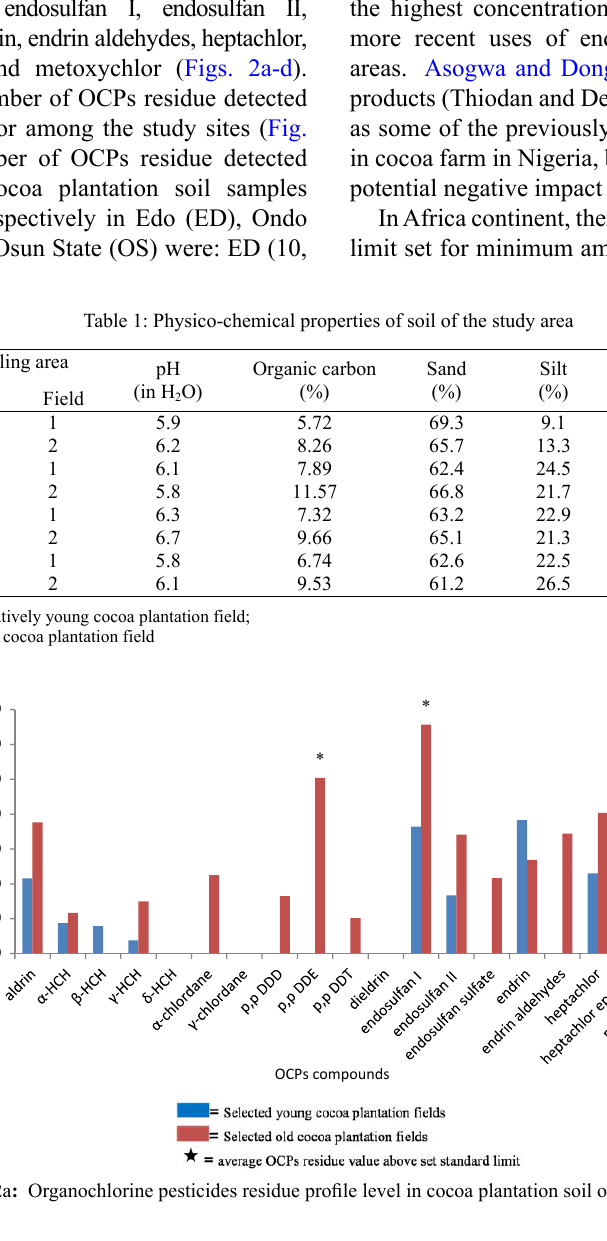
Fig. 2b : Organochlorine pesticides residue profile level in cocoa plantation soil of Ekiti State